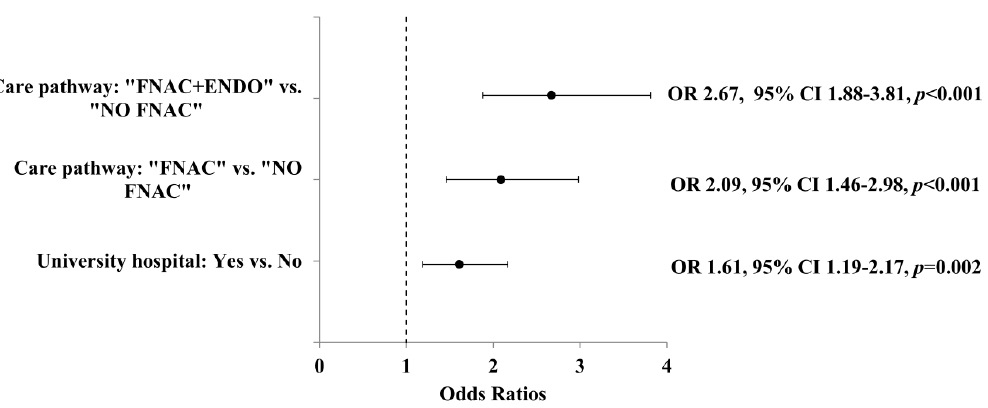
Figure 3. Multivariate analysis of factors having an influence on thyroid cancer diagnosis among patients operated on for thyroid nodules between 2012 and 2015. FNAC: Fine-Needle Aspiration Cytology; ENDO: endocrinology consultation.